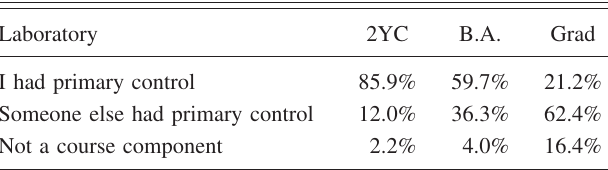
TABLE III. Existence of and control over laboratory component of the course.